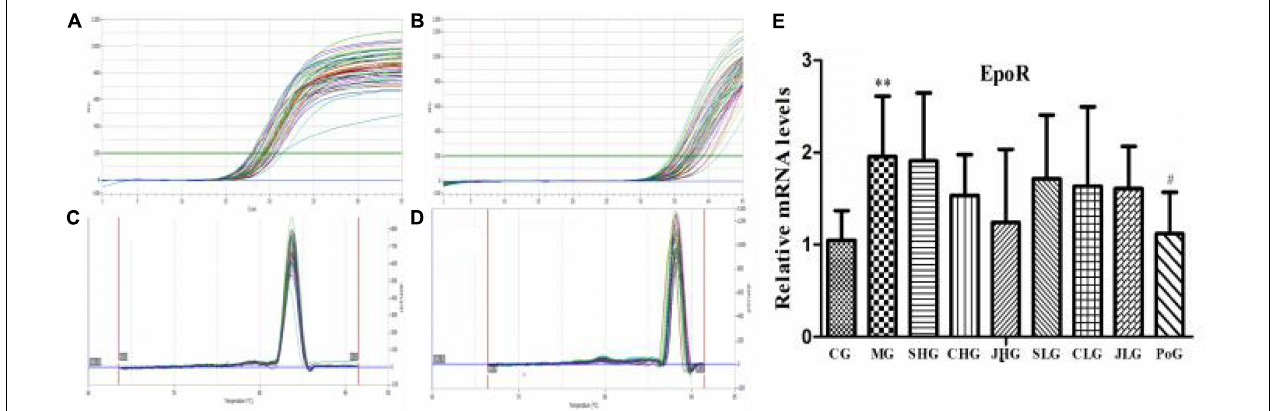
FIGURE 3 | The mRNA expression of EpoR in hepar. (A) β -actin and (B) Epo are PCR amplification curve. (C) β -actin and (D) Epo are dissociation curve. (E) The relative mRNA levels of EpoR. CG, control group, MG, model group, SHG, Curcumae Longae Radix group, CHG, Stir-frying Curcumae Longae Radix with vinegar group, JHG, Stir-frying Curcumae Longae Radix with wine group, SLG, Curcuma phaeocaulis Radix group, CLG, Stir-frying Curcuma phaeocaulis Radix with vinegar group, JLG, Stir-frying Curcuma phaeocaulis Radix with wine group and PoG, positive group. Values were mean ± SD ( n = 6). ∗∗ p < 0.01 vs. control group; # p < 0.05 vs. model group.